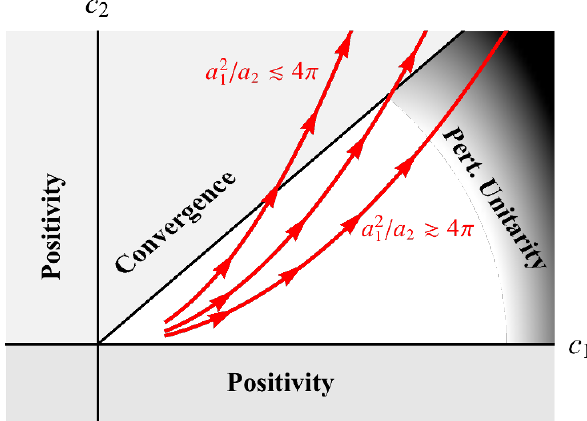
Figure 1 . In the plane spanned by c 1 and c 2 (the two leading coe(cid:14)cients of the propagator deriva- tive expansion) we show how the constraints from (i) positivity, (ii) convergence, (iii) perturbative unitarity single out a theoretically-allowed bounded region. An experimental measurement of a 1 and a 2 (the (cid:12)rst two terms in a momentum expansion) selects the curve c 2 = c 2 a 2 =a 2 . Examples 1 1 of these curves (for di(cid:11)erent values of a 2 =a 2 ) are shown by solid red lines, which are generated 1 by varying the cuto(cid:11) mass M . The value of M increases along the direction of the arrows. The stronger bound on M comes from convergence when a 2 =a 2 . 4 (cid:25) and from perturbative unitarity 1 when a 2 =a 2 & 4 (cid:25) 1